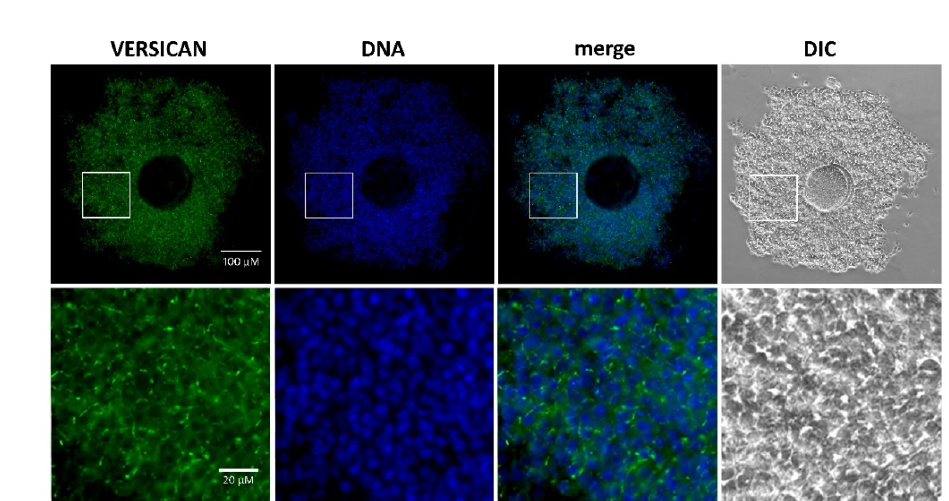
Figure 3. ( A ) Temporal pattern of versican V1 cleavage in hormone-stimulated OCCs cultured in vitro in the absence and in the presence of follicular fluid (FF). Groups of 15 OCCs were stimulated for 26 or 44 h with FSH / LH in the absence (PVP) or presence of 5% FF. At the indicated times of culture, they were digested with Streptomyces hyaluronidase (H), and matrix (M) and cell (C) extracts were analyzed by western blot with anti-DPEAAE-V1 antibody. Actin immunodetection was performed to compare sample loading. A representative blot of three independent experiments is shown. Immunostaining of porcine OCCs cultured for 26 h without ( B ) and with ( C ) FSH / LH in the presence of FBS. The OCCs were labeled with anti-DPEEAE versican primary antibody, and with secondary antibody Alexa Fluor 488. Nuclei were co-stained with DAPI. The OCCs were mounted on glass slides and examined with an Olympus AX70 microscope equipped with a DP30BW CCD camera. Note the punctuate positivity only in the matrix of expanded OCCs (panel C , higher magnification).